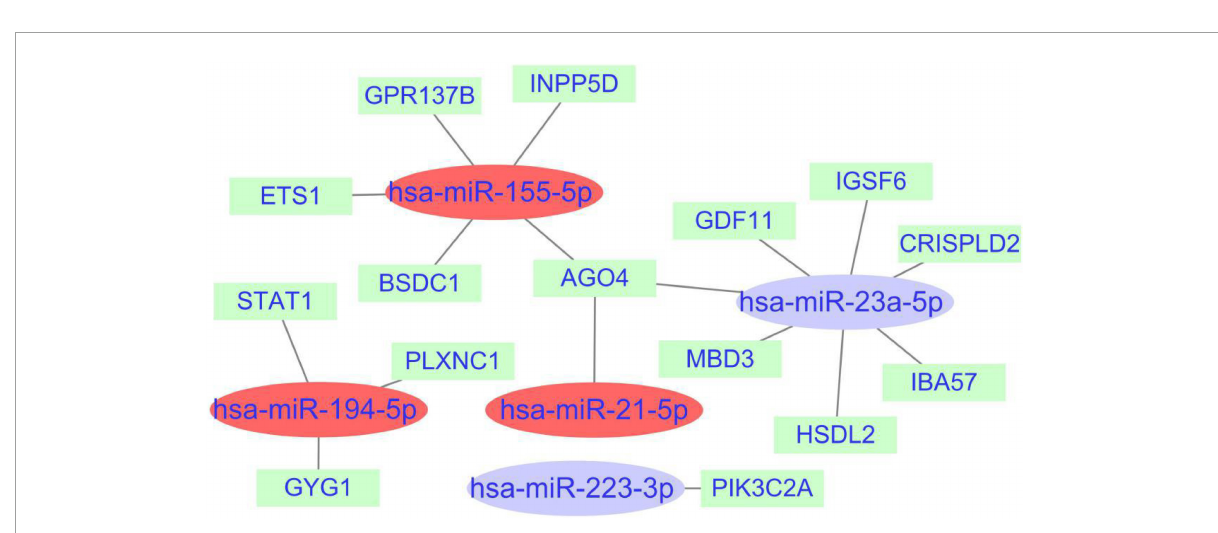
FIGURE8 miRNAs-shared genes regulatory network. The ovals represent miRNAs and squares represent shared genes. The red ovals represent miRNAs associated with interferon gamma signaling